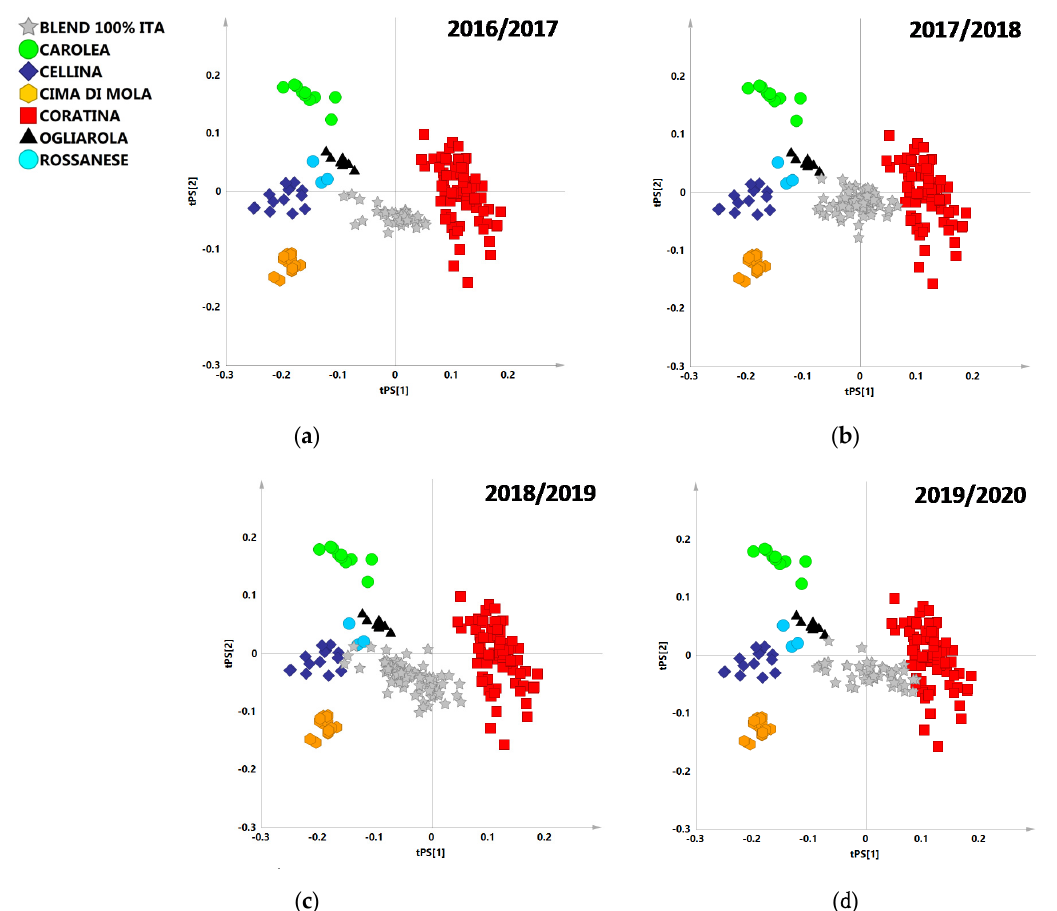
Figure 3. PLS-DA predicted scores plot for the reference model data sets. Prediction set samples, from 2016/2017 ( a ) 2017/2018 ( b ), 2018/2019 ( c ), and 2019/2020 ( d ) were indicated as grey five points star. 6 components gave R 2 X = 0.953; R 2 Y = 0.750; Q 2 = 0.711. Table 2. Misclassification table summarizing the classified observations in the 2016/17, 2017/18, 2018/2019, and 2019/2020 prediction sets.